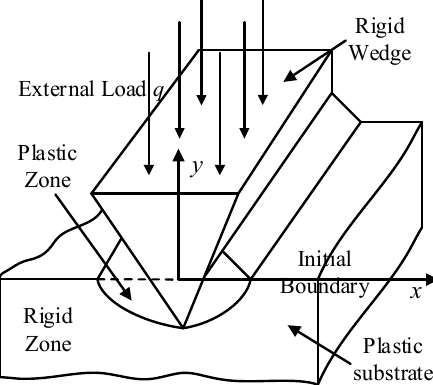
Figure 9. Pressure Model of Rigid Wedge.